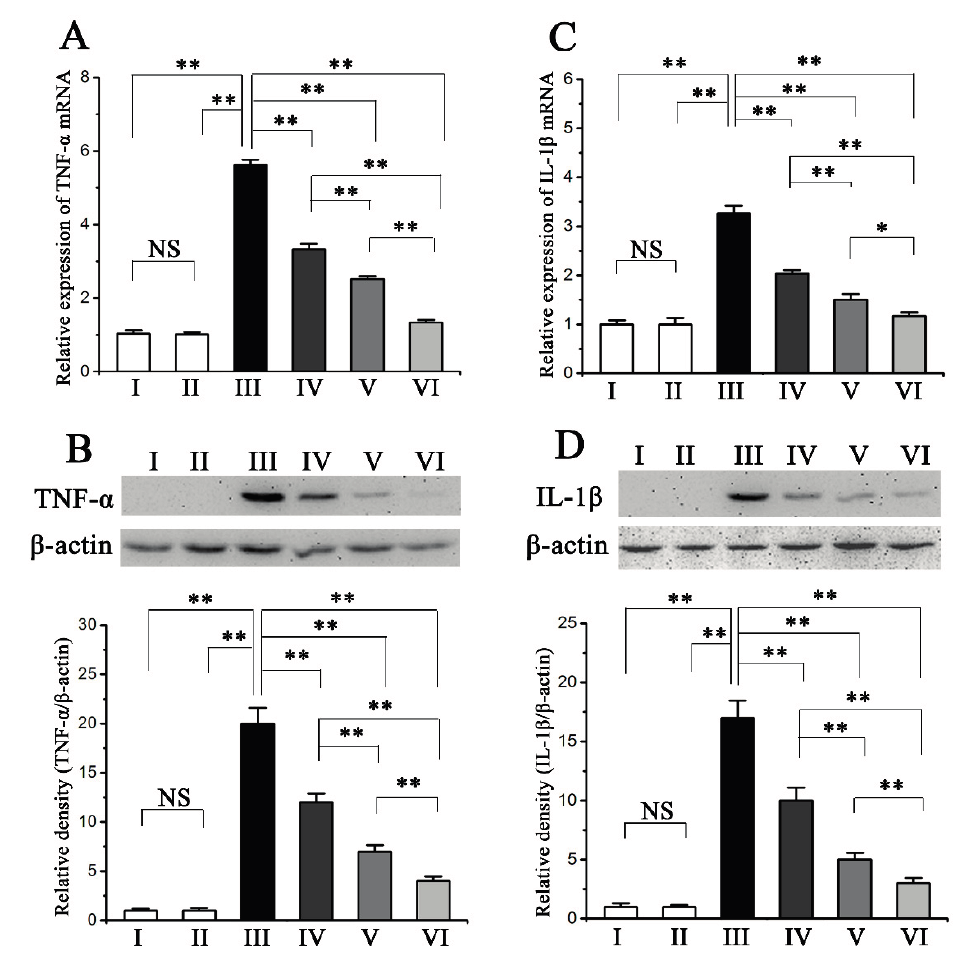
Figure 3. Pretreatment effects of procyanidin B2 on CCl 4 -induced expression of inflammatory cytokine. Quantitative real time PCR was perform to measure TNF- α ( A ) and IL-1 β ( C ) mRNA expression levels in response to CCl 4 and procyanidin B2; Western blot analysis was perform to measure TNF- α ( B ) and IL-1 β ( D ) protein expression levels in response to CCl 4 and procyanidin B2. Values expressed as mean ± SE in each group. NS: no significant, * p < 0.05, ** p < 0.01, n = 7. Animals were divided into following groups: I, normal control; II, procyanidin B2 control; III, model; IV, procyanidin B2 (25 mg·kg − 1 ) + CCl 4 ; V, procyanidin B2 (50 mg·kg − 1 ) + CCl 4 ; and VI, procyanidin B2 (100 mg·kg − 1 ) + CCl 4